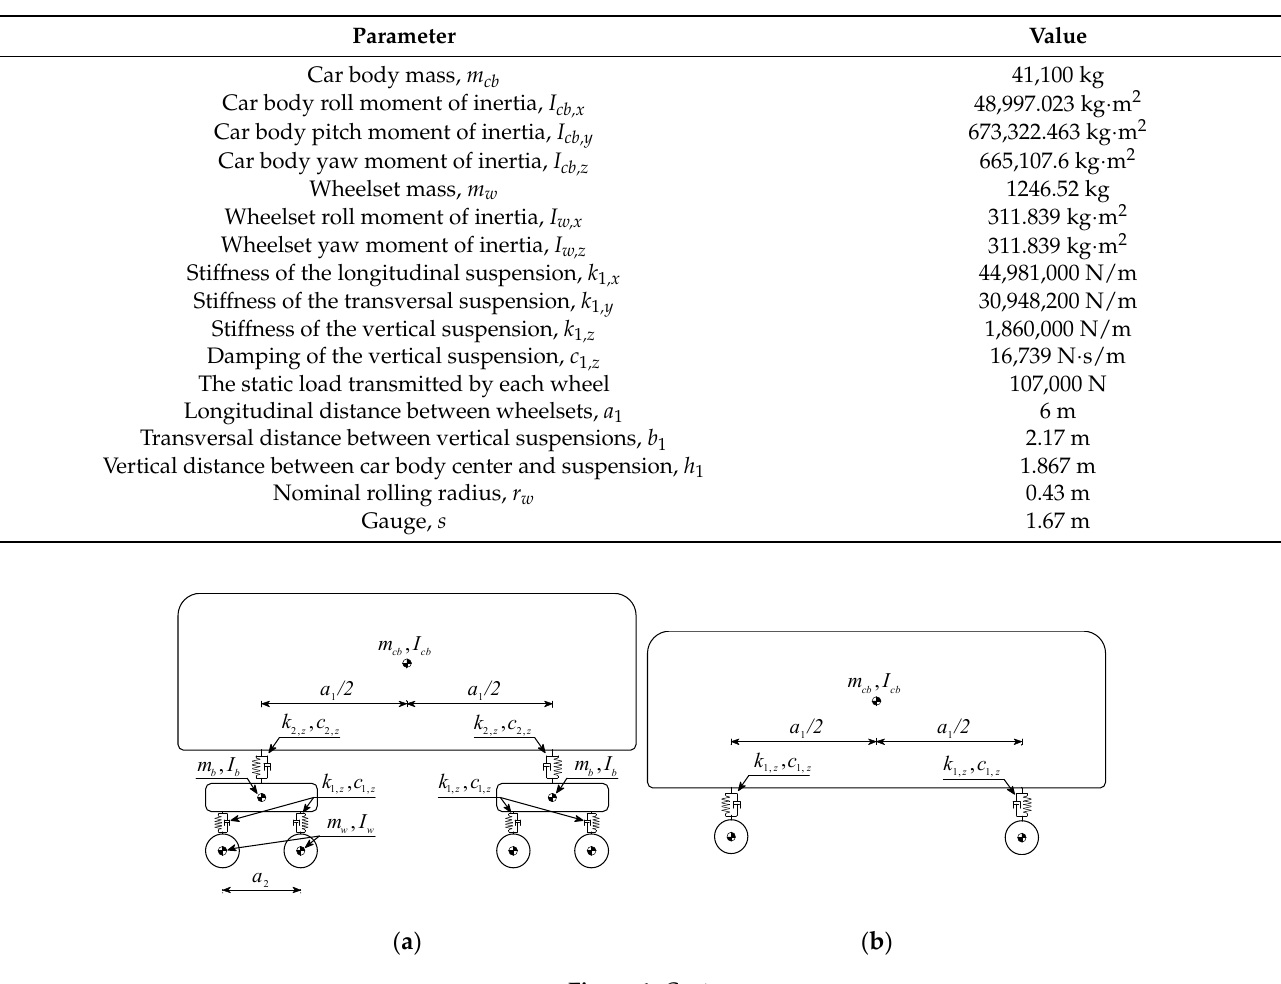
Table 2. Parameters for the freight wagon (adapted from Neto et al. (2019) [40]).